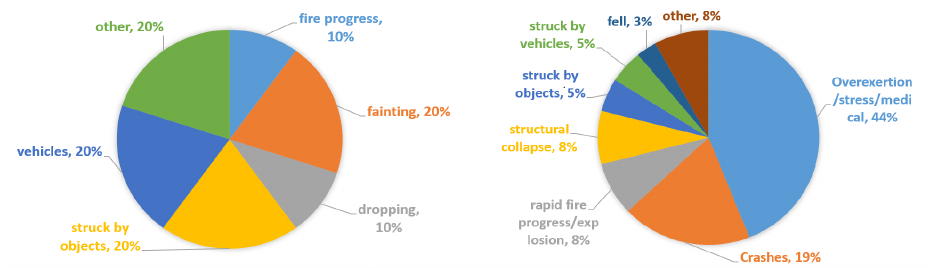
Figure 1. Comparison of the causes of firefighters’ fatalities in China ( left ) and in the USA ( right ), 2018 [1,2].